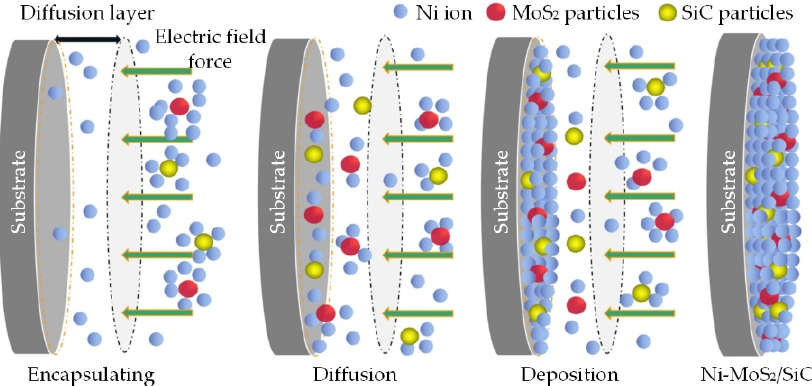
Figure 5. A schematic illustration of electrodeposition process.